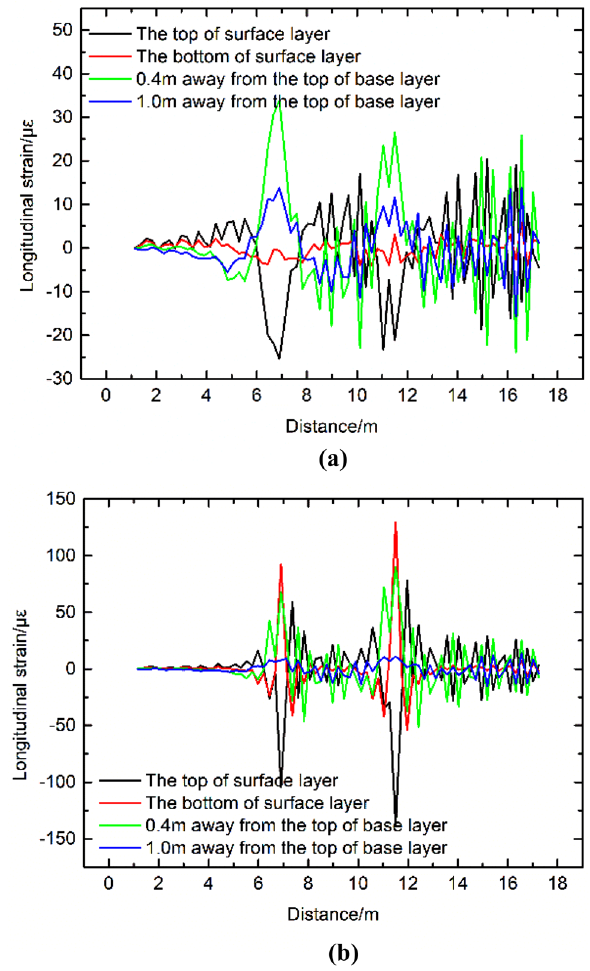
Fig. 3 Vertical strain of a the centerline of the two wheels and b a single wheel